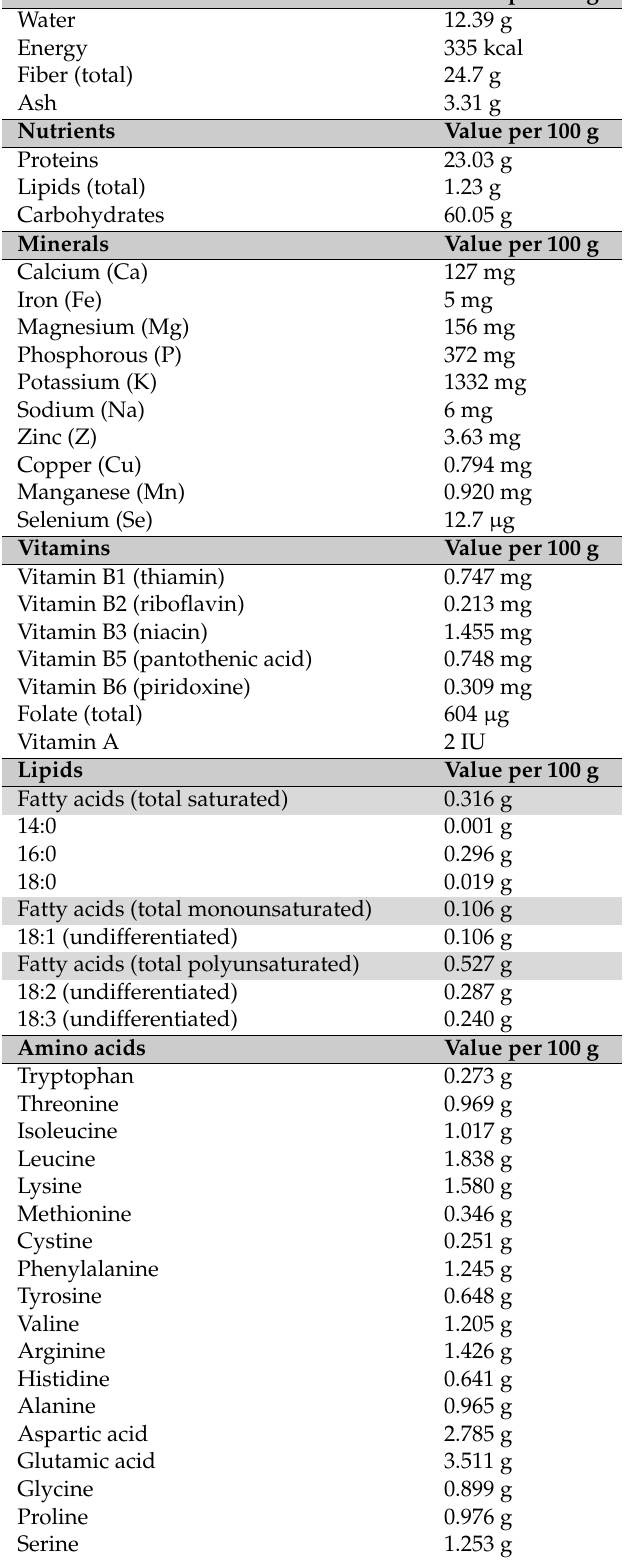
Table 1. Nutritional composition of common bean ( Phaseolus vulgaris L.), cranberry, mature seed, raw